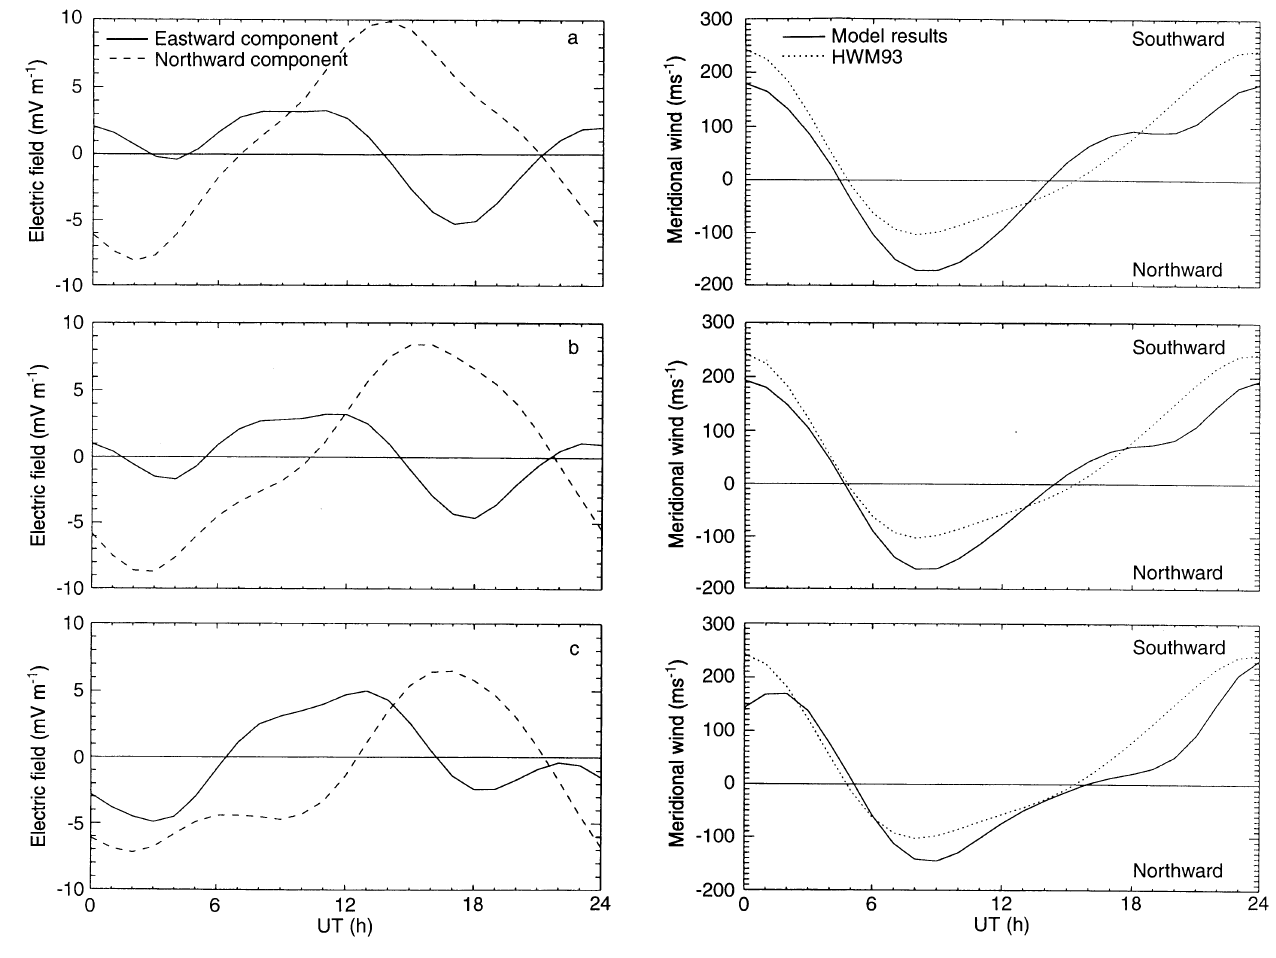
Fig. 12a (cid:177) c. Eastward- and northward-electric-field components versus UT (left panels) and the meridional neutral wind velocity at an altitude of 300 km in comparison with the HWM93-model